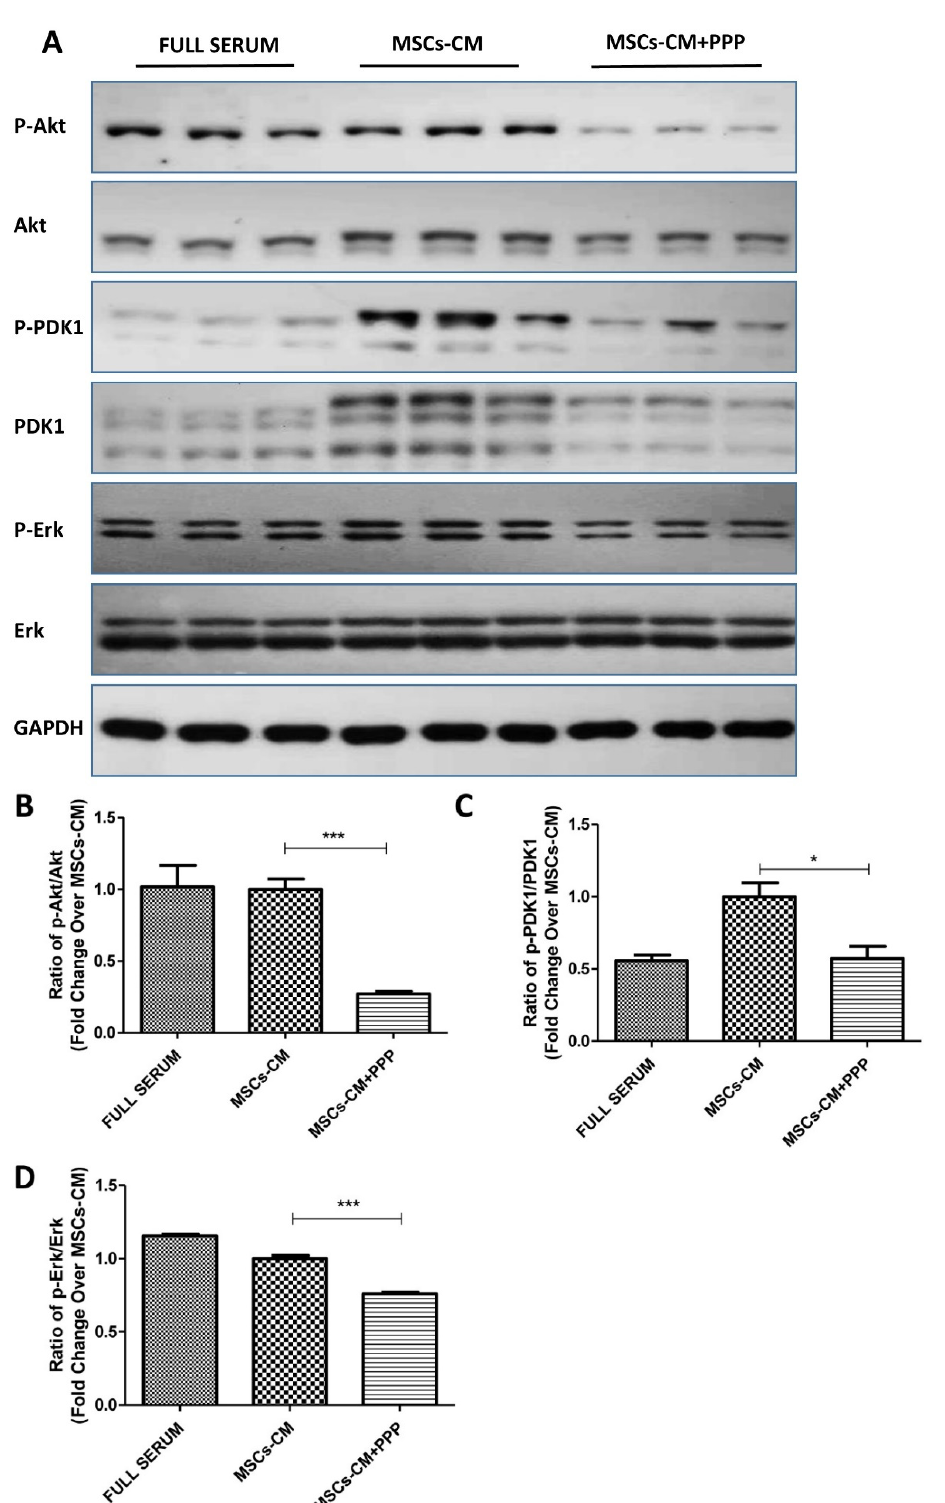
Figure 4. Western blot analysis of IGF1-mediated downstream signaling pathways. ( A ) PPCs were cultured under the conditions of full serum and MSCs-CM with or without PPP for 48 h and harvested for analyses of the phosphorylation of Akt, PDK1, and ERK1/2. ( B, C, D ) Quantification was conducted using ImageJ software. (n = 3 per group; *p < 0.05, **p < 0.01, ***p < 0.001. All data are expressed as means + SEM).